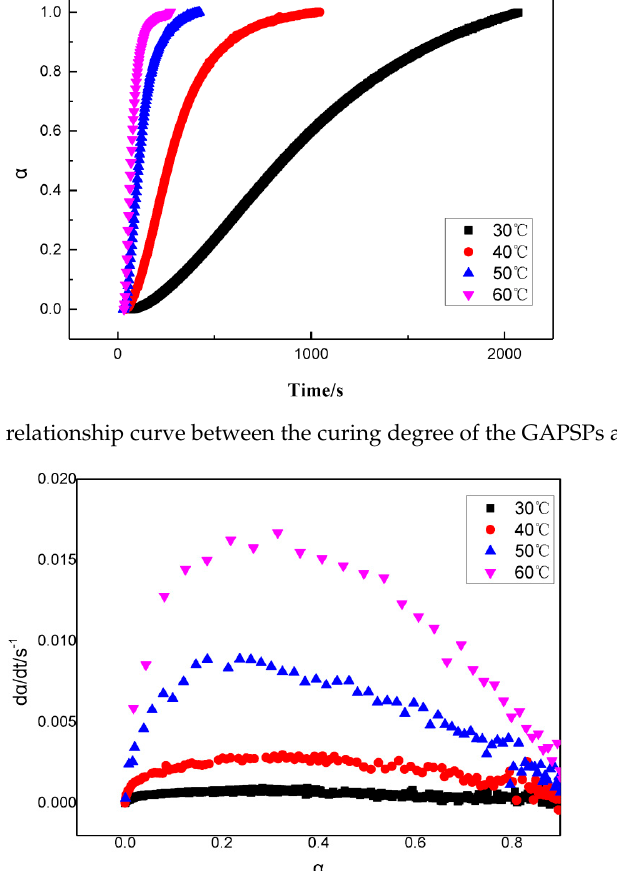
Figure 2. The relationship curve between the curing degree of the GAPSPs and time.